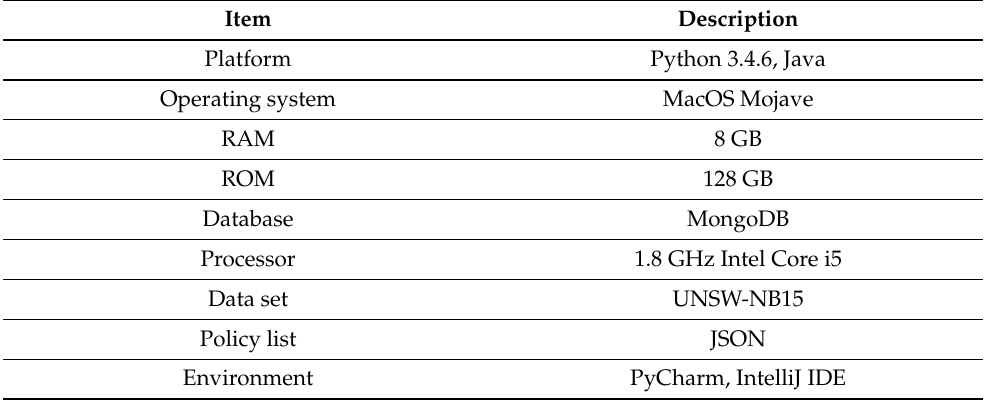
Table 1. Materials Used.